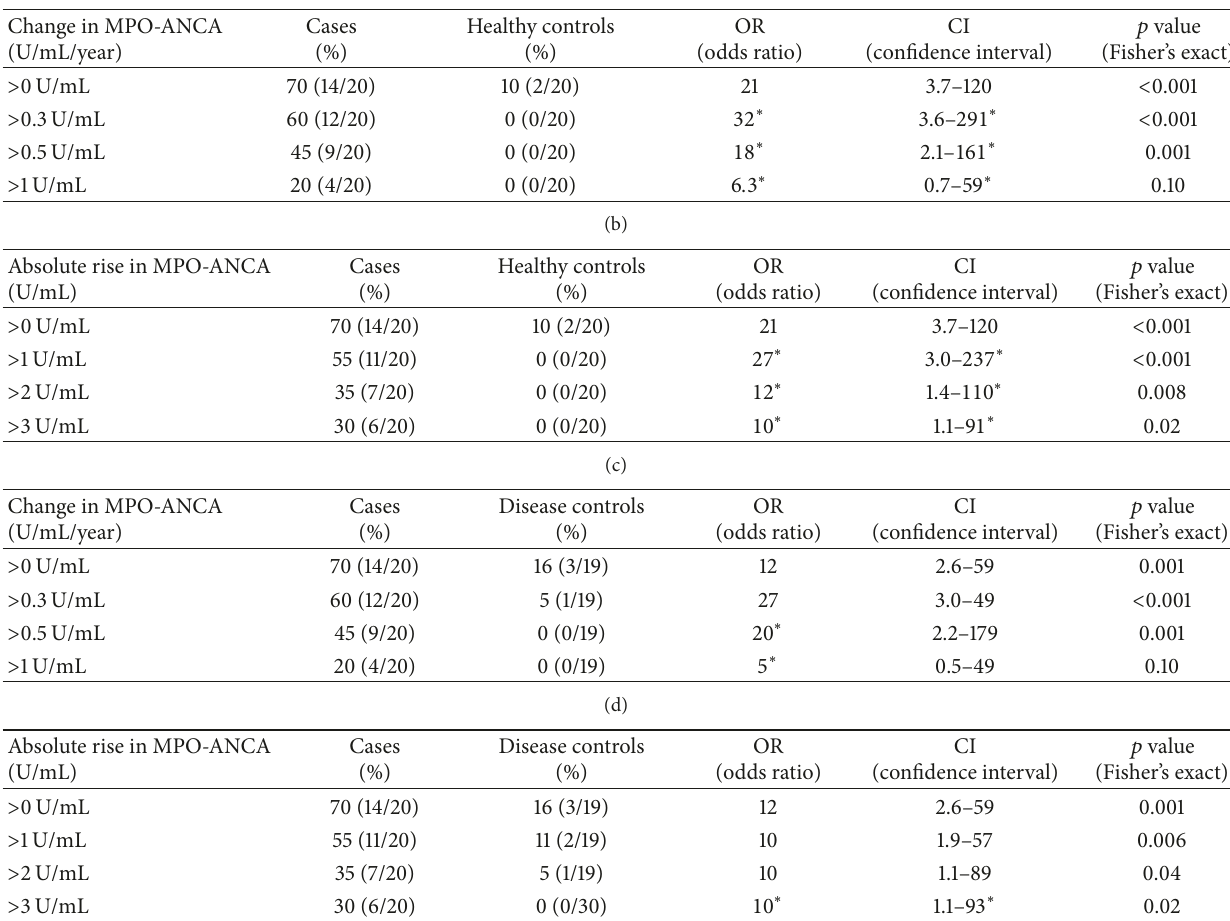
Table 4: The percent of PLN patients with MPO-ANCA absolute change and rate of rise over time above specific thresholds compared to matching healthy and SLE without LN disease controls. Only 20 cases and healthy controls and 19 SLE without LN disease controls had multiple samples to evaluate change over time. ∗ Estimated due to actual infinite value.